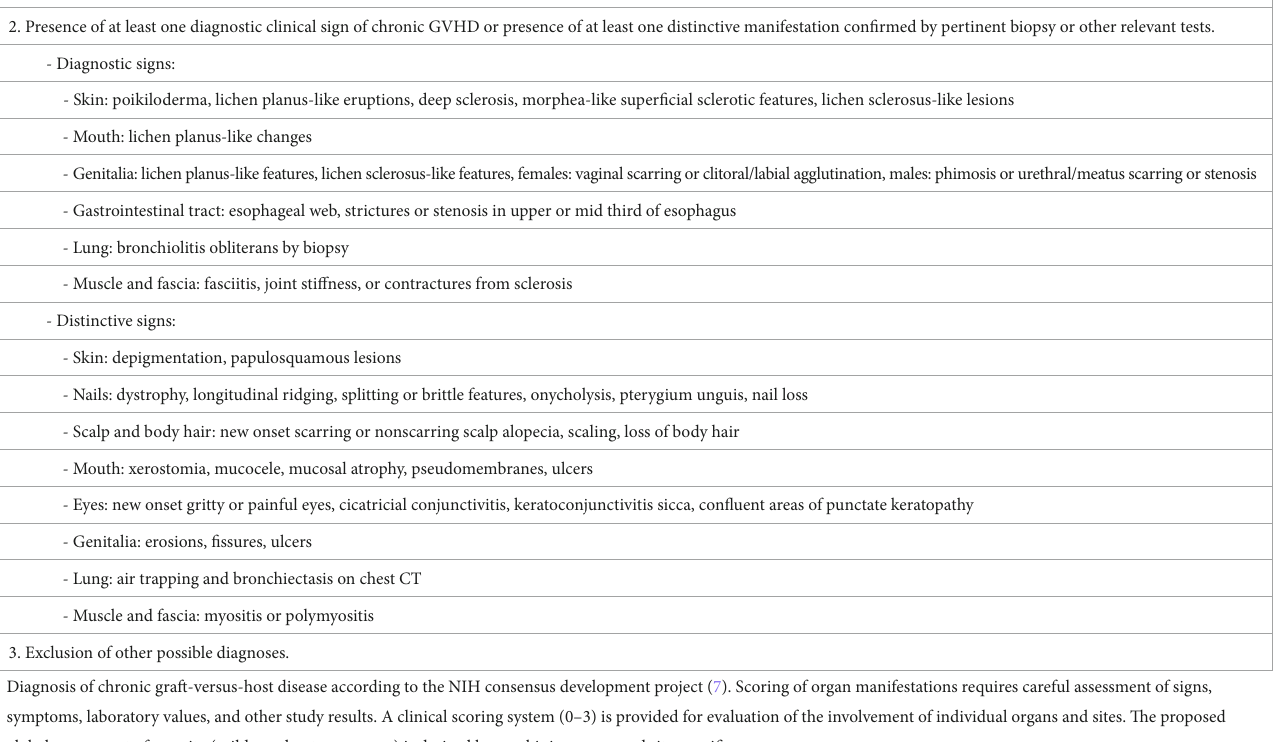
TABLE 1 Criteria for clinical trials in chronic graft-versus-host